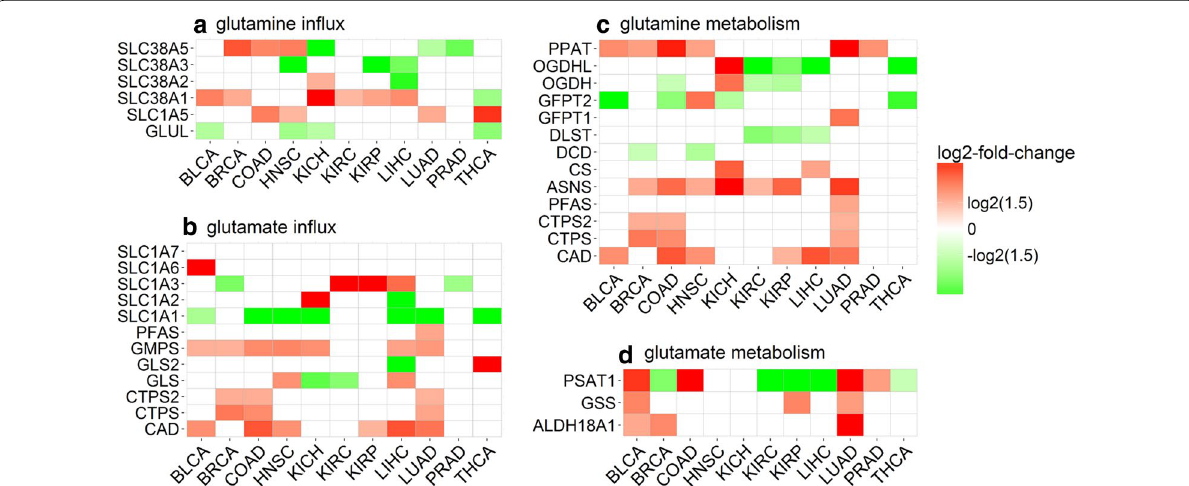
Fig. 1 Differential expression of importer and synthase genes for a glutamine and b glutamate influx, and metabolisms of c glutamine and d glutamate in 11 types of cancer. BLCA, bladder urothelial carcinoma; BRCA, breast invasive carcinoma; COAD, colon adenocarcinoma; HNSC, head and neck squamous cell carcinoma; KICH, kidney chromophobe; KIRC, kidney renal clear cell carcinoma; KIRP, kidney renal papillary cell carcinoma; LIHC, liver hepatocellular carcinoma; LUAD, lung adenocarcinoma; PRAD, prostate adenocarcinoma; THCA, thyroid carcinoma; SLC1A5, solute car- rier family 1 member 5; GLUL, glutamate–ammonia ligase; GLS, glutaminase; PFAS, phosphoribosylformylglycinamidine synthase; GMPS, guanine monophosphate synthase; CAD, carbamoyl-phosphate synthetase 2, aspartate transcarbamylase, and dihydroorotase; CTPS, CTP synthase 1; PPAT, phosphoribosyl pyrophosphate amidotransferase; OGDHL, oxoglutarate dehydrogenase-like; OGDH, oxoglutarate dehydrogenase; GFPT1, glu- tamine-fructose-6-phosphate transaminase 1; DSLT, dihydrolipoamide S-succinyltransferase; DCD, dermcidin; CS, citrate synthase; ASNS, asparagine synthetase; PSAT1, phosphoserine aminotransferase 1; GSS, glutathione synthetase; ALDH18A1, aldehyde dehydrogenase 18 family member A1